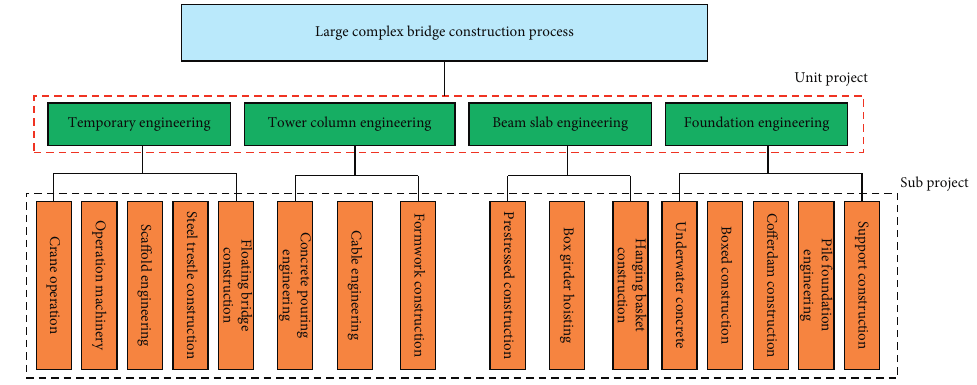
Figure 2: Organizational chart of construction procedures for large and complex bridges. Table 1: Decomposition of the large complex bridge construction process.